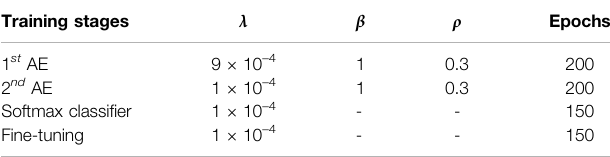
TABLE 1 | List of training parameters for the different training stages of the DNNs, where λ is the weight decay, β is the sparsity penalty term and ρ is the sparsity